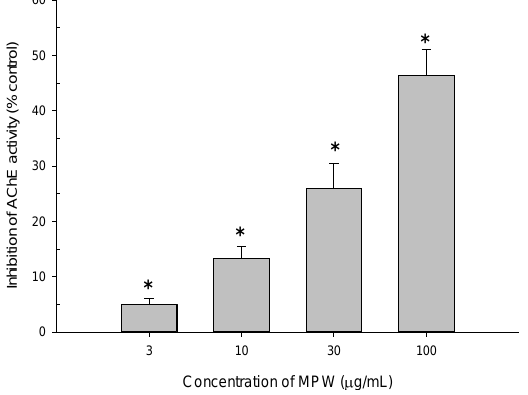
Figure 7 . Effect of MPW on AChE activity. The AChE enzyme activities were determined using Ellman’s method with some modifications in the absence or presence of MPW at various concentrations, as described in the Materials and Methods. The data are expressed as percentages of inhibition of the enzyme activity measured in the absence of MPW. Each data point represents the mean ± S.E.M. from at least three independent experiments conducted in duplicate (*, p < 0.05 vs. the enzyme activity measured in the absence of MPW).